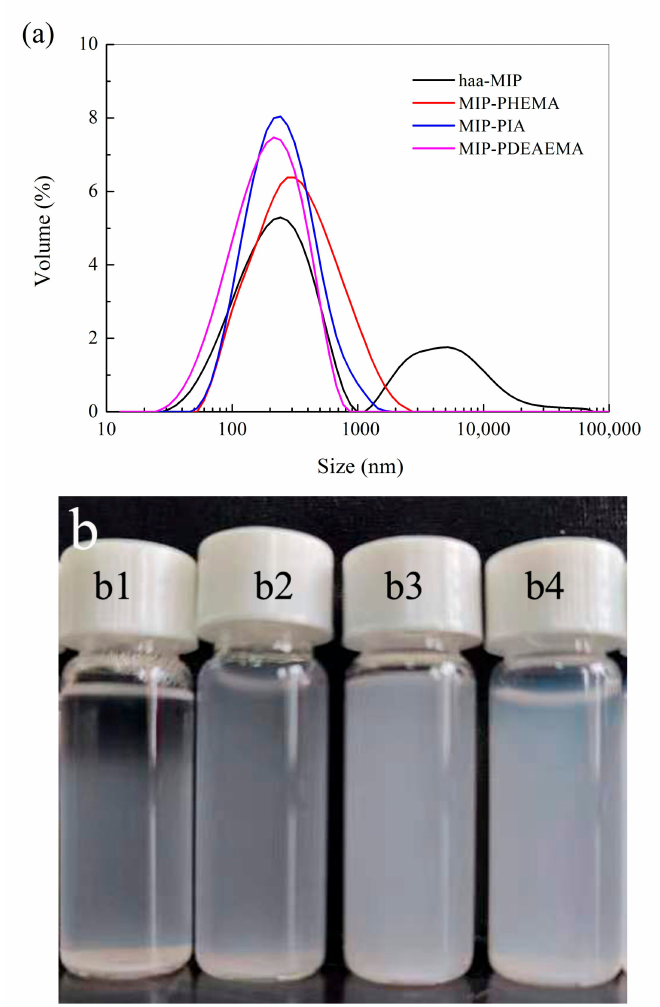
Figure 5. ( a ) Size distribution of haa-MIP and MIP-HSs in water. ( b ) The dispersion photographs of haa-MIP and MIP-HSs in pure water after settling down for 1 h at 25 ◦ C. The samples of b1–b4 are haa-MIP, MIP-PHEMA, MIP-PIA, and MIP-PDEAEMA,